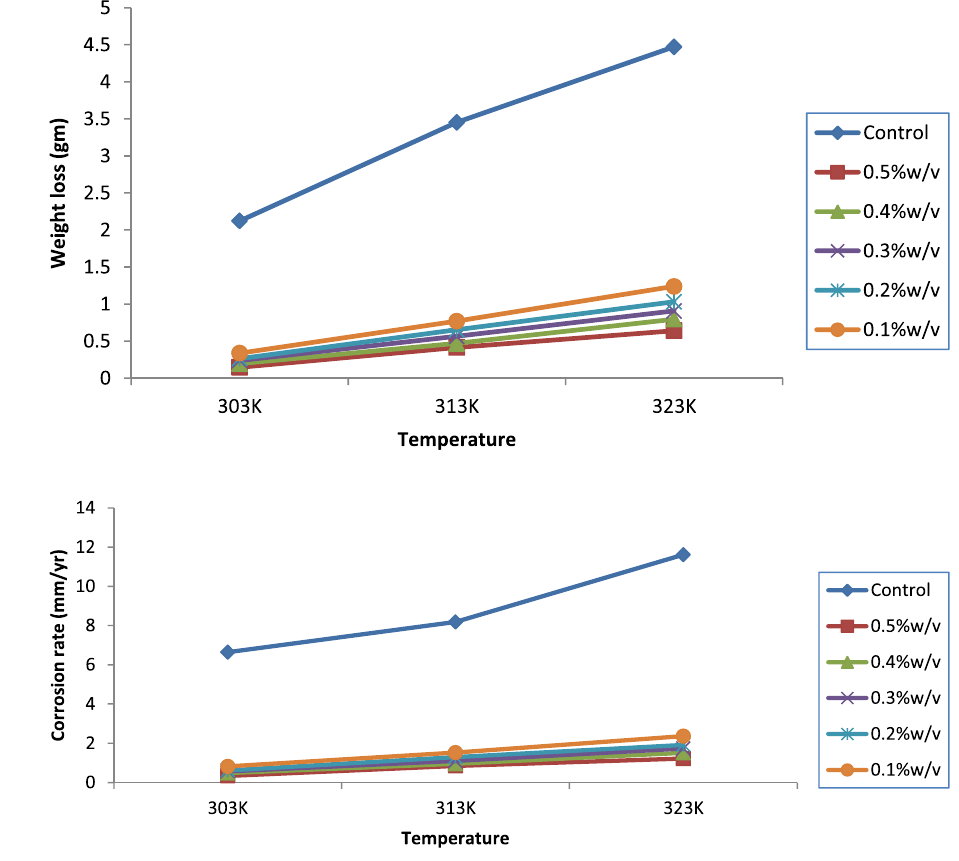
Fig. 2 Corrosion rates of Gongronema latifolium obtained by gravimetric method at different temperatures